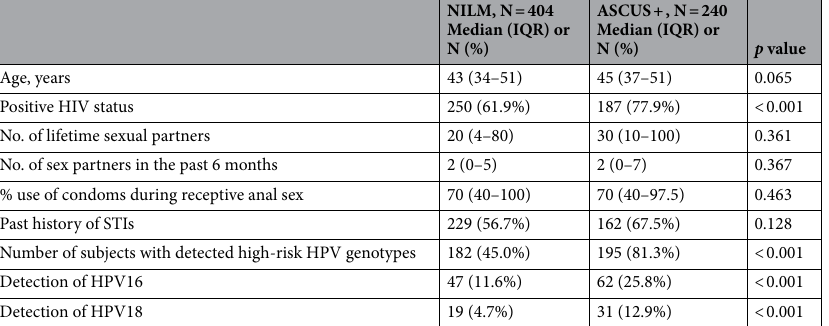
Table 2. Findings among participants with NILM and ASCUS +. NILM negative for intraepithelial lesion or malignancy, ASC-US atypical squamous cell of undetermined significance, MSM men who have sex with men, STIs sexually transmitted infections, IQR interquartile range, hr-HPV high-risk types of human papillomavirus.